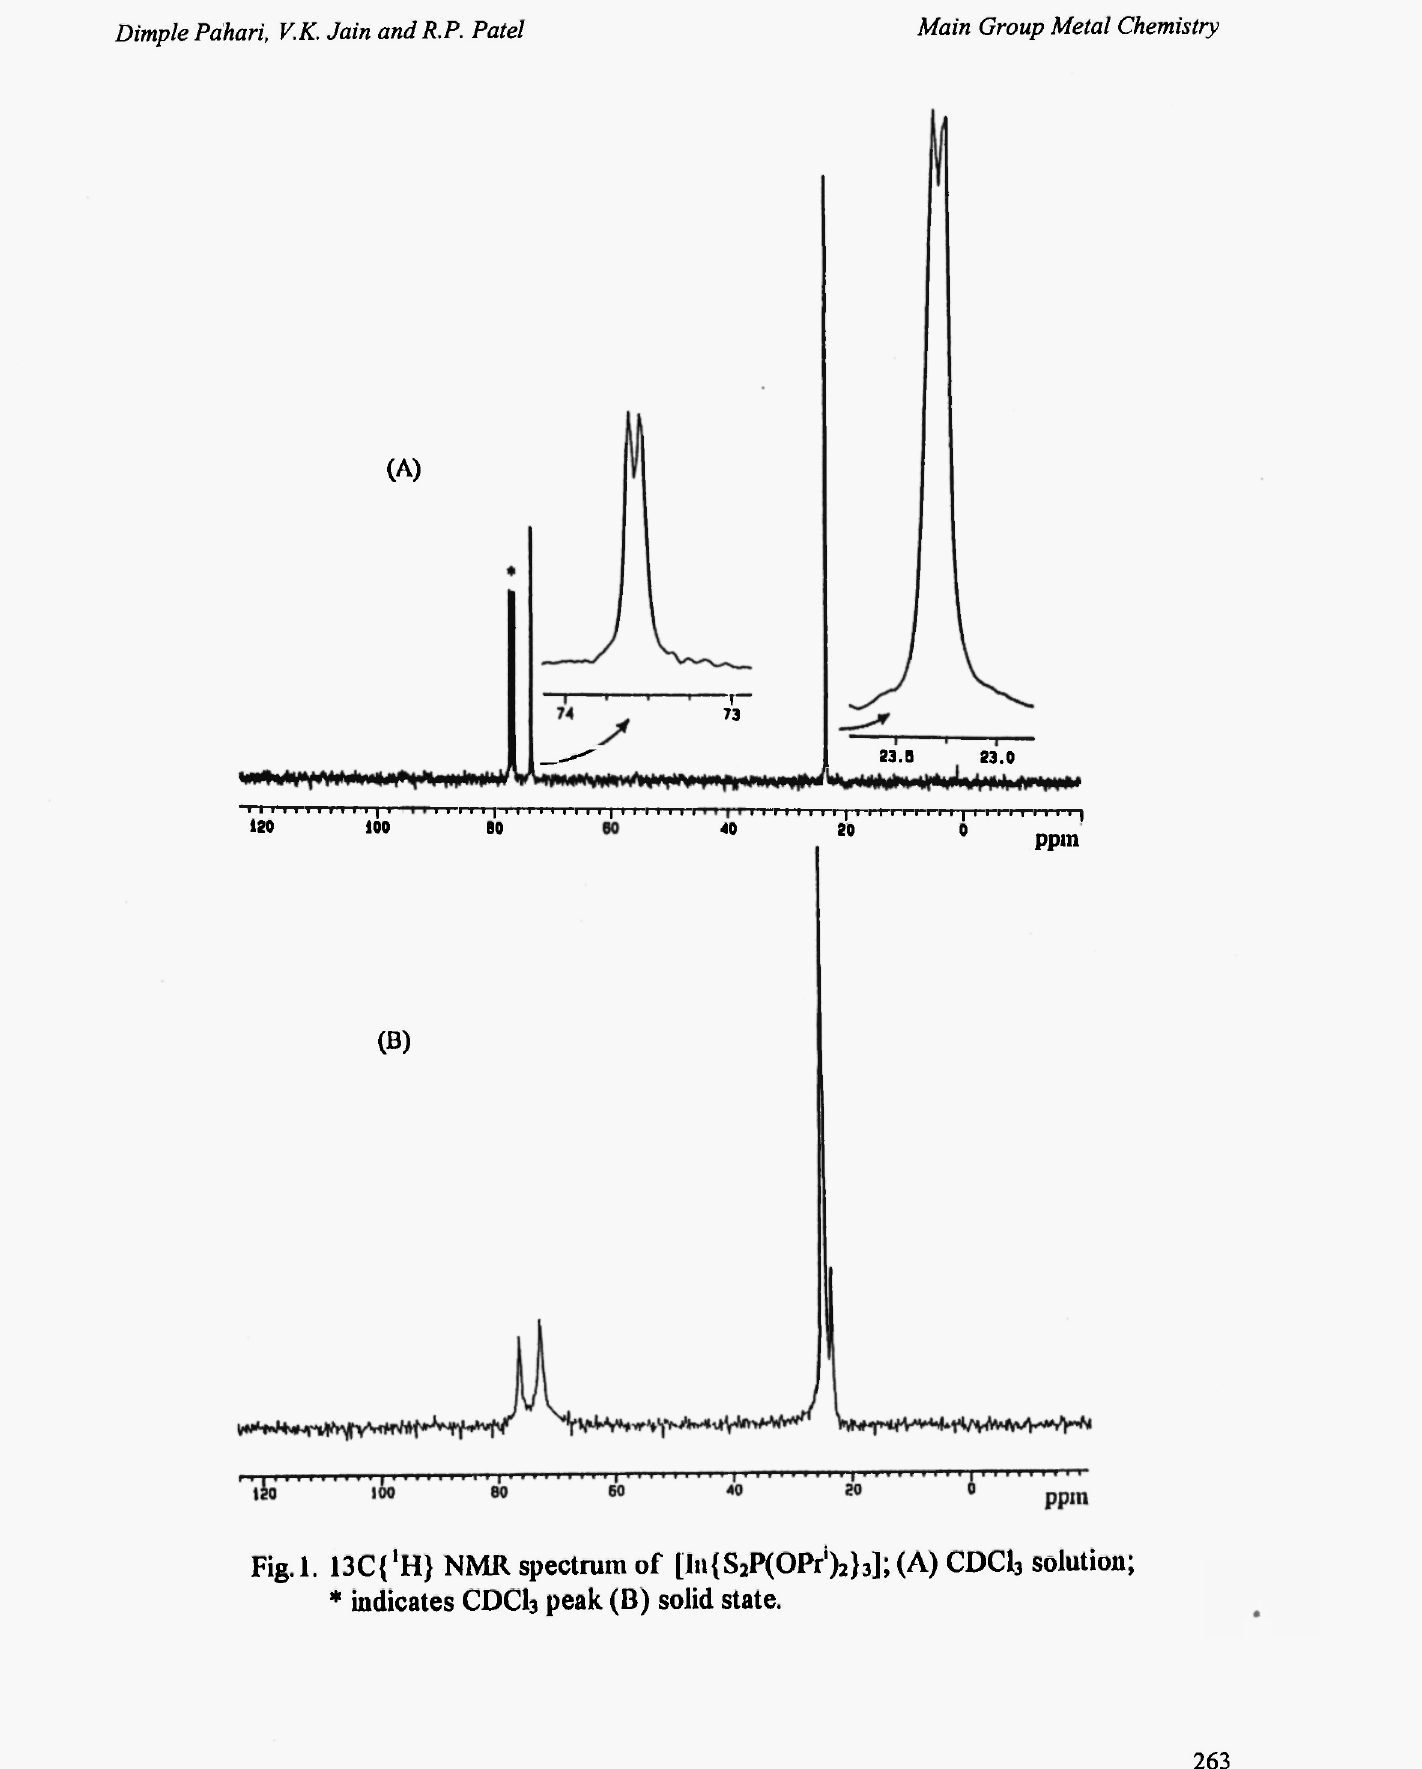
Fig. 1. 13C{'H} NMR spectrum of 1!»{8 * indicates CDCI3 peak (B) solid